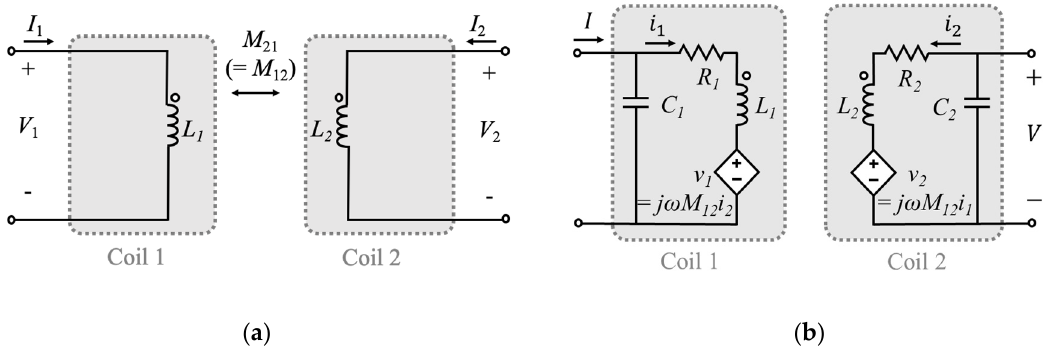
Figure 1. The equivalent circuit model: ( a ) Ideal two coils; and ( b ) real coils with parasitic capacitors.